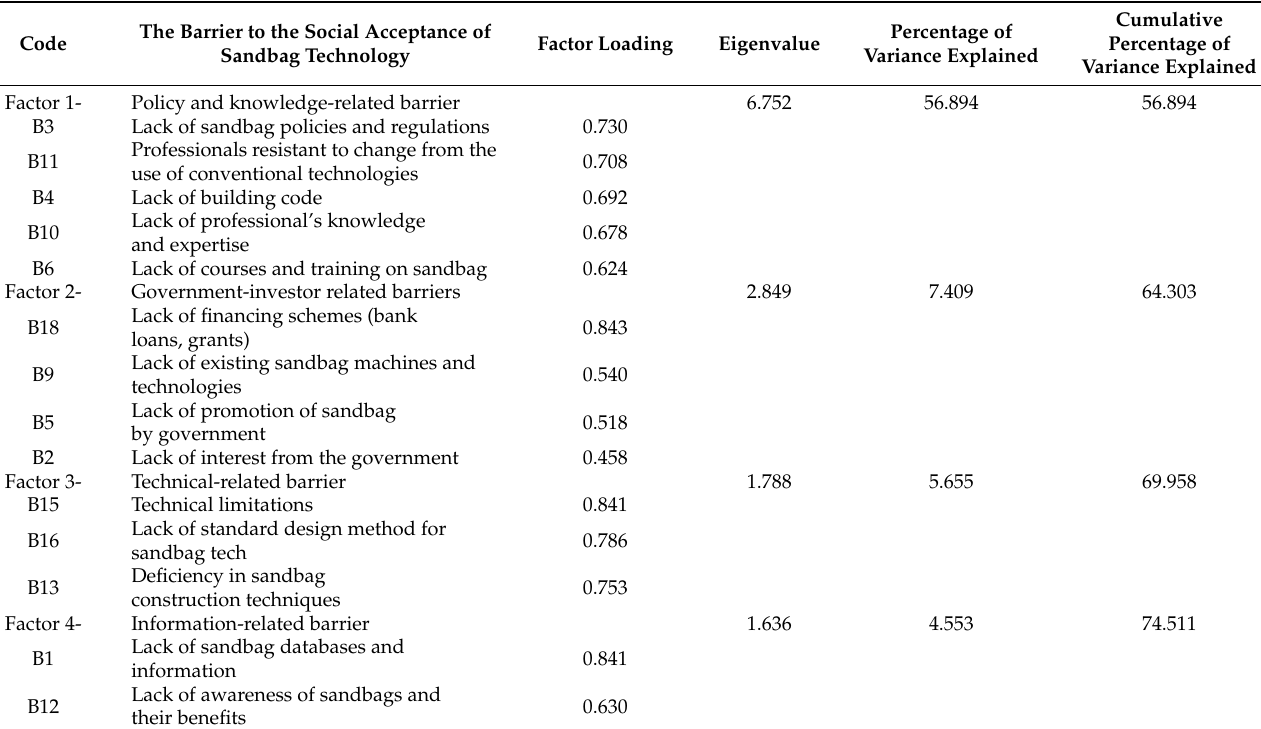
Table 3. Varimax rotation factor structure on the critical